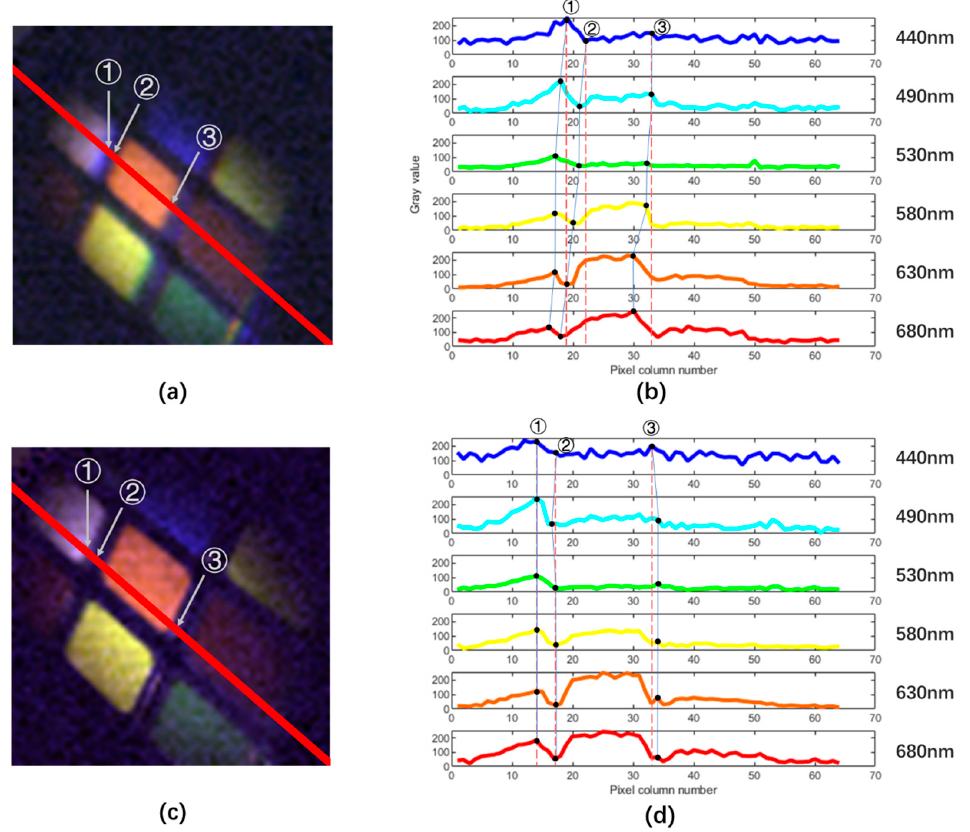
Figure 9. Comparison of the performance of chromatic aberration correction. The intensity profiles across the red lines in the reconstructed images of ( a ) the control group and ( c ) the TV lens group vs. pixel number for different wave bands are shown in ( b , d ). Three groups of pixels ① , ②, and ③ are selected and in ( b , d ) are connected across the spectral bands with a blue line, while the vertical red dotted lines denote the abscissa of the chosen points with the first band (440 nm) as the reference origin.